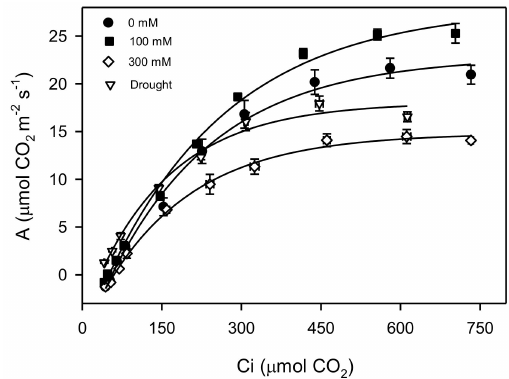
Figure 4. CO 2 response curve between net photosynthesis (A) and variable intercellular CO 2 concen- trations on leaves of Phragmites karka under the 0, 100, and 300 mM NaCl and drought.